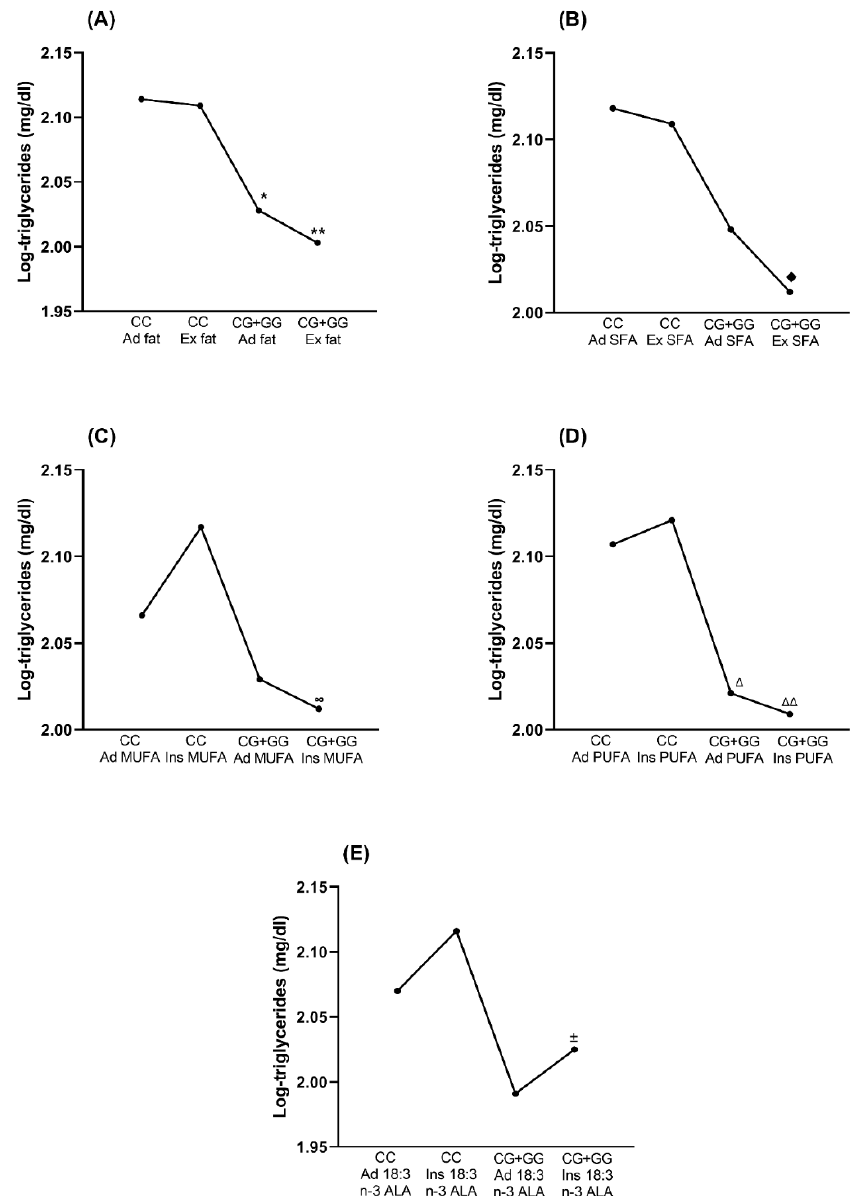
Figure 4. Triglyceride levels according to the rs3812316 C > G SNV and its association with ( A ) Total fat intake, ( B ) Saturated fatty acids, ( C ) Monounsaturated fatty acids, ( D ) Polyunsaturated fatty acids, and ( E ) alpha-linolenic acid in women. Data are shown as estimated mean. Fat intake and specific fatty acid intake were categorized according to the position of the Academy of Nutrition and Dietetics [19]. Triglycerides were log10-transformed to apply ANCOVA (analysis of covariance) analysis, adjusted for HDL-c, total cholesterol, waist circumference, HOMA-IR, and energy intake; Bonferroni correction was used to test for multiple comparisons. A p -value < 0.05 was considered statistically significant. SFA: Saturated fatty acids, MUFA: Monounsaturated fatty acids, PUFA: Polyunsaturated fatty acids, ALA: alpha-linolenic acid, n-3: omega-3, HDL-c: High-density lipoprotein